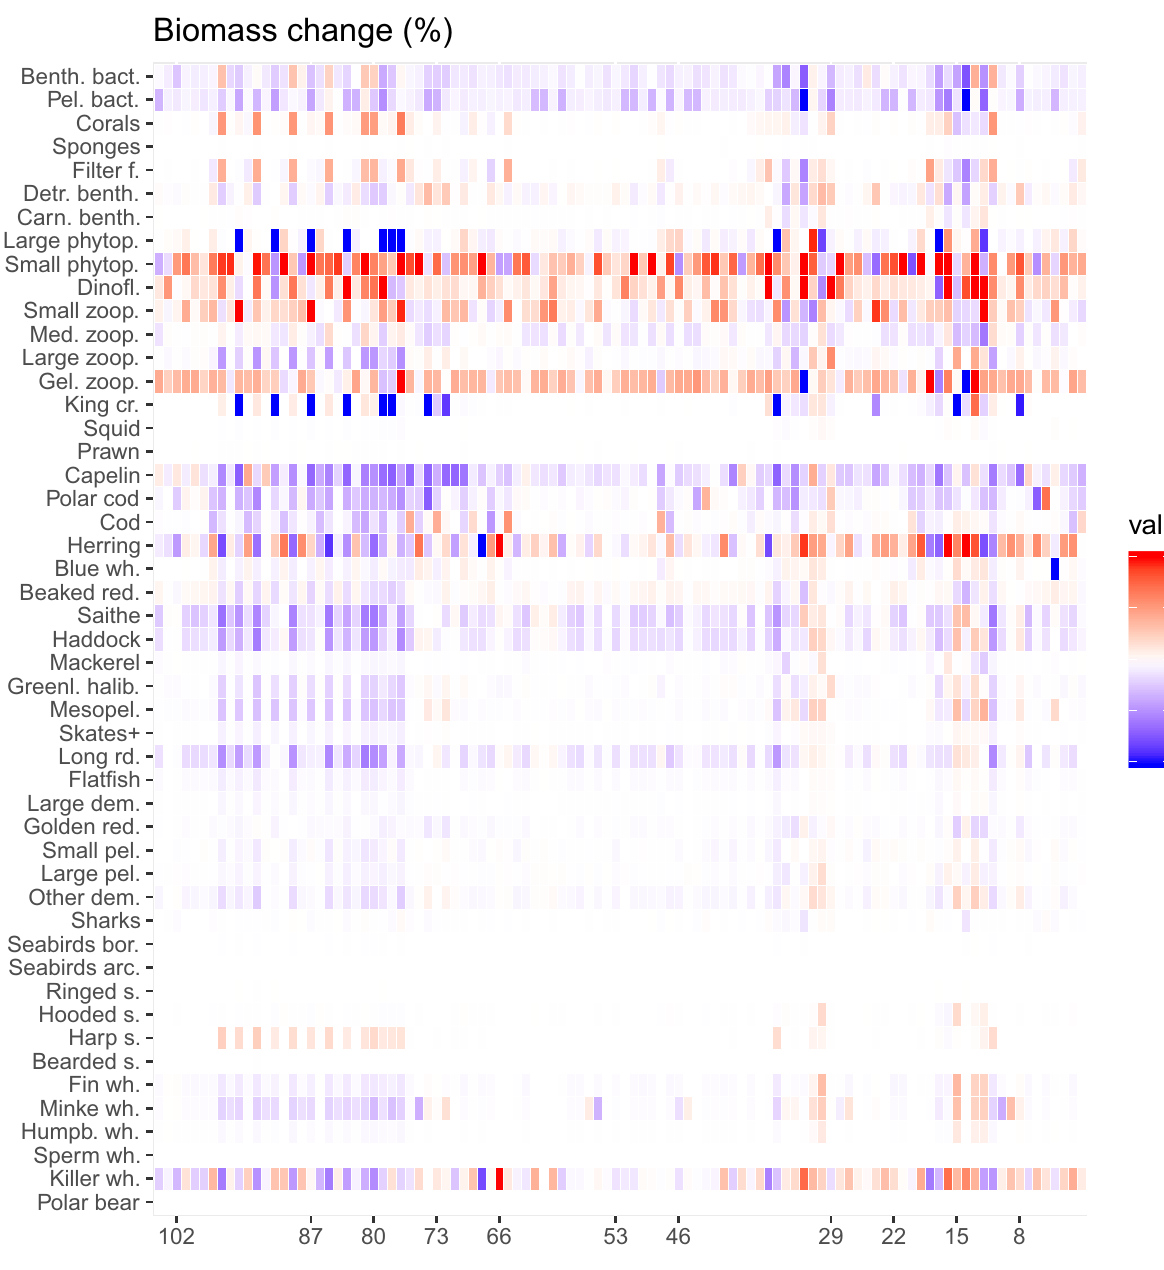
bearKiller Polar Fig 3. Component response to perturbations. Biomass change for all species in all runs. Dark red/dark blue areas are changes above or below 60%. While fish and marine mammals experience a negative response to a majority of the simulations, the opposite is found in the zooplankton, due to predator-prey interactions. Harp seal ( Pagophilus groenlandicus ) is one of a few species to have mostly positive responses (although The model was run with no variability in physics or fisheries pressure, which limits the possi- bilities to compare the model output to the temporal development of the ‘real world’. However, one rule-of-thumb that has been applied in several Atlantis models (e.g. [37] is that the compo- nents should remain within 0.5–1.5 of the initial biomass levels after the burn-in period. The